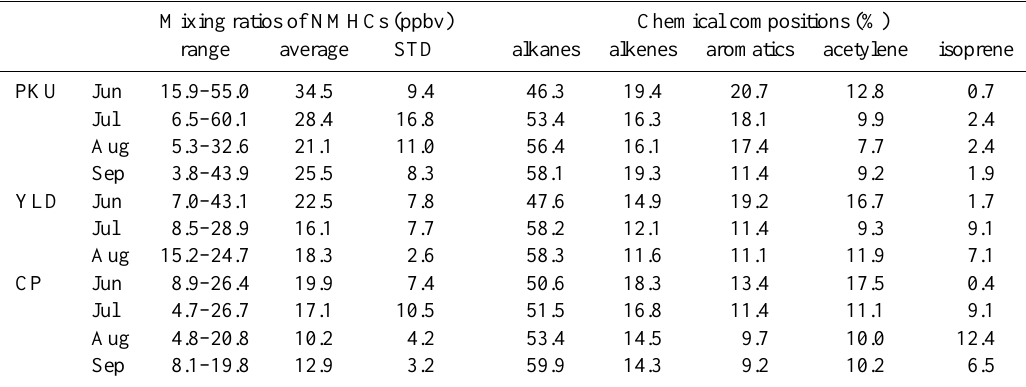
Table 4. Mixing ratios and chemical speciations of NMHCs measured in 2008. Mixing ratios of NMHCs (ppbv) Chemical compositions (%) range average